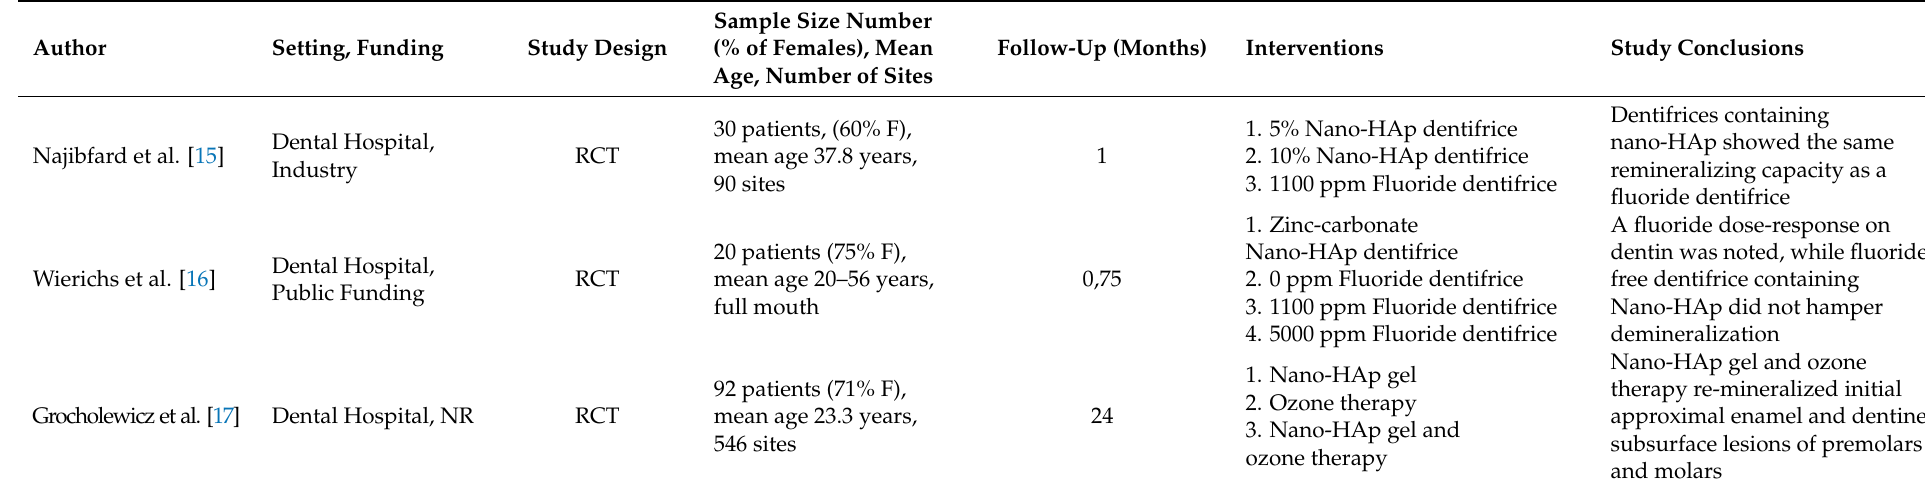
Table 1. Summary of Nano-HAp application in tissue remineralization.